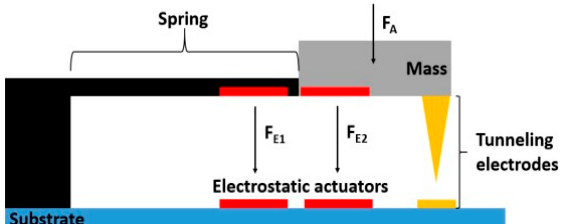
Figure 1. Principle of the tunneling accelerometer with its main components like the wafer substrate, the spring-mass-system, the electrostatic actuators and the tunneling section.